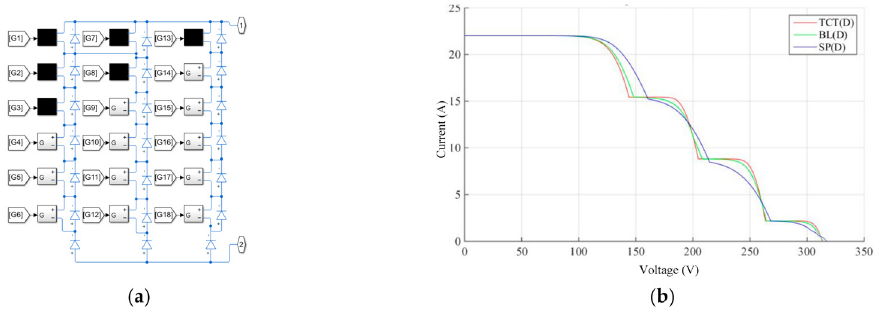
Figure 14. Output characteristics of different circuit configurations. ( a ) Partial shading conditions. ( b ) I–V curve.